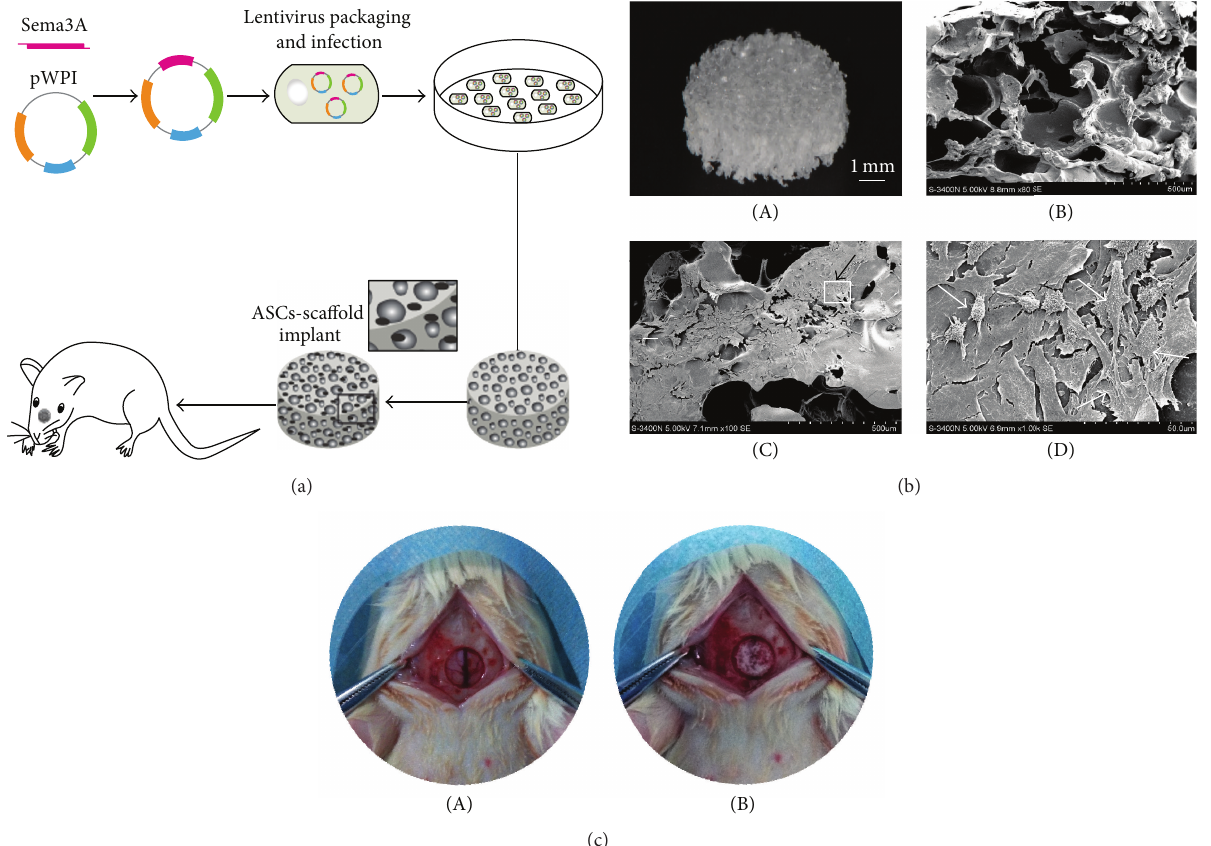
Figure 3: The fabrication of PLGA scaffolds engrafted with ASCs. (a) Schematic diagram of experiment procedure. (b) The morphology of PLGA scaffold-ASCs implants: (A) gross observation, (B) the lateral view of the scaffold without cells observed by SEM, (C) the surface view of the scaffold-ASCs implants under SEM, and (D) magnification to the inset in Figure 3(b)(C) and the cells were indicated by white arrow. (c) The critical size bone defect before (A) and after the transplantation of scaffold- ASCs implants